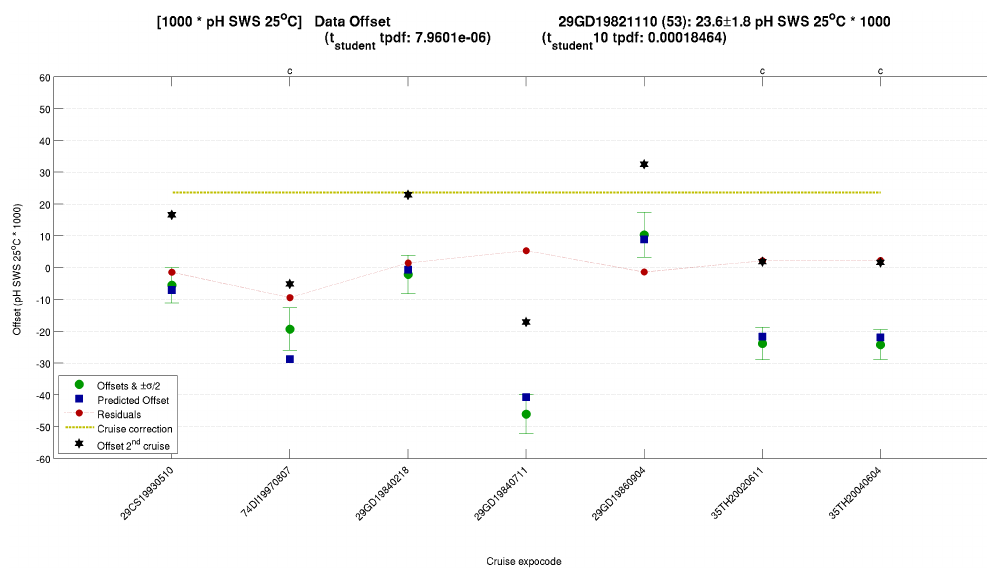
Figure 9. Cruise crossover information plot for 29GD19821110